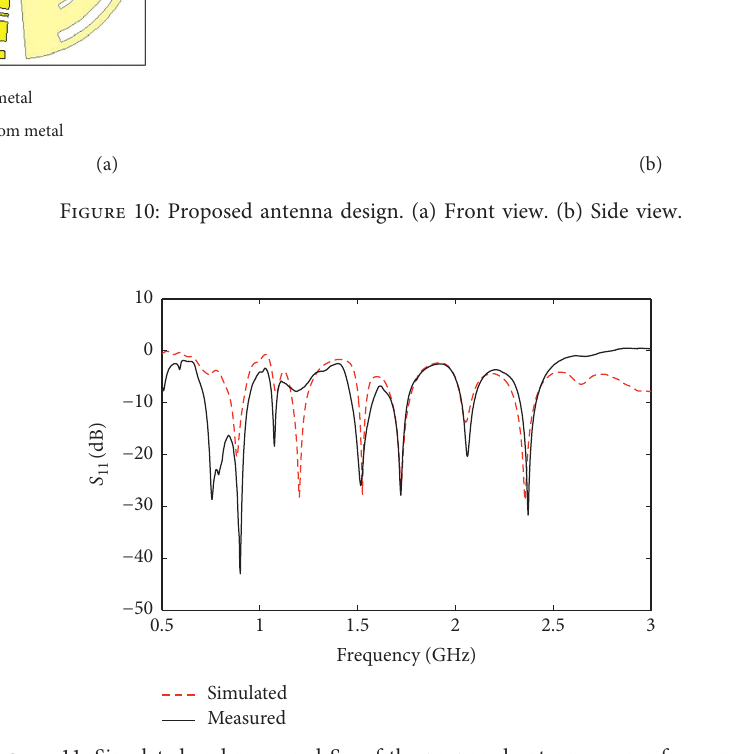
of the proposed antenna versus frequency. 11